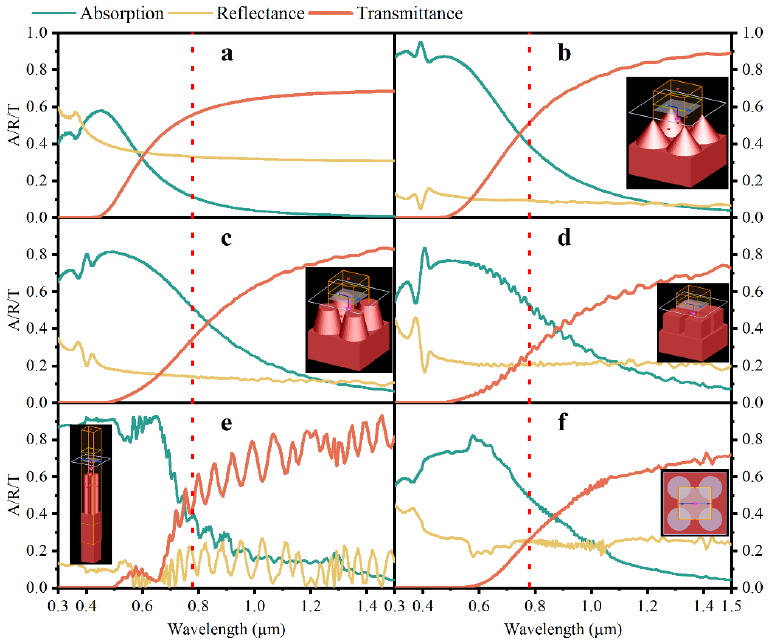
Figure 4. Optical response curves (absorption-A, reflectance-R, transmittance-T) of different microstructures shown in Figure 3, including ( a ) planar silicon, ( b ) cone, ( c ) round column, ( d ) square column, ( e ) Si-NWAs and ( f ) Si-NHAs. The inset corresponds to 3D models in